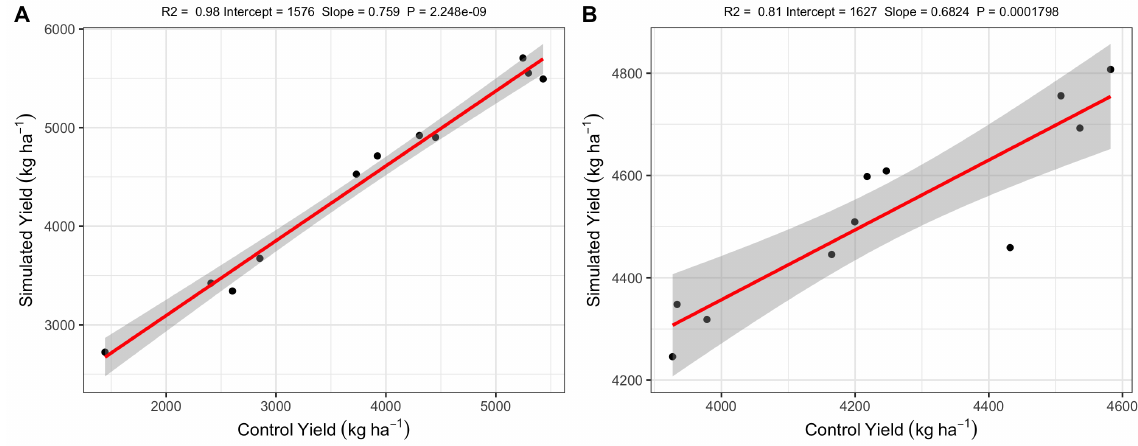
Figure 3. Correlations between yearly simulated and observed (control) total yields corresponding to the 1983–1993 calibration data set for Guayas ( A ) and Los Ríos ( B ) Provinces. The red lines represent fitted linear regressions lines, and the gray-shaded areas represent 95% confidence intervals. Furthermore, indices of agreement (d) were 0.90 (Guayas) and 0.67 (Los Ríos). The percentage of biased data (PBIAS) was relatively low with 17 % and 6% for Guayas and Los Ríos, respectively. The values were close to those observed during data